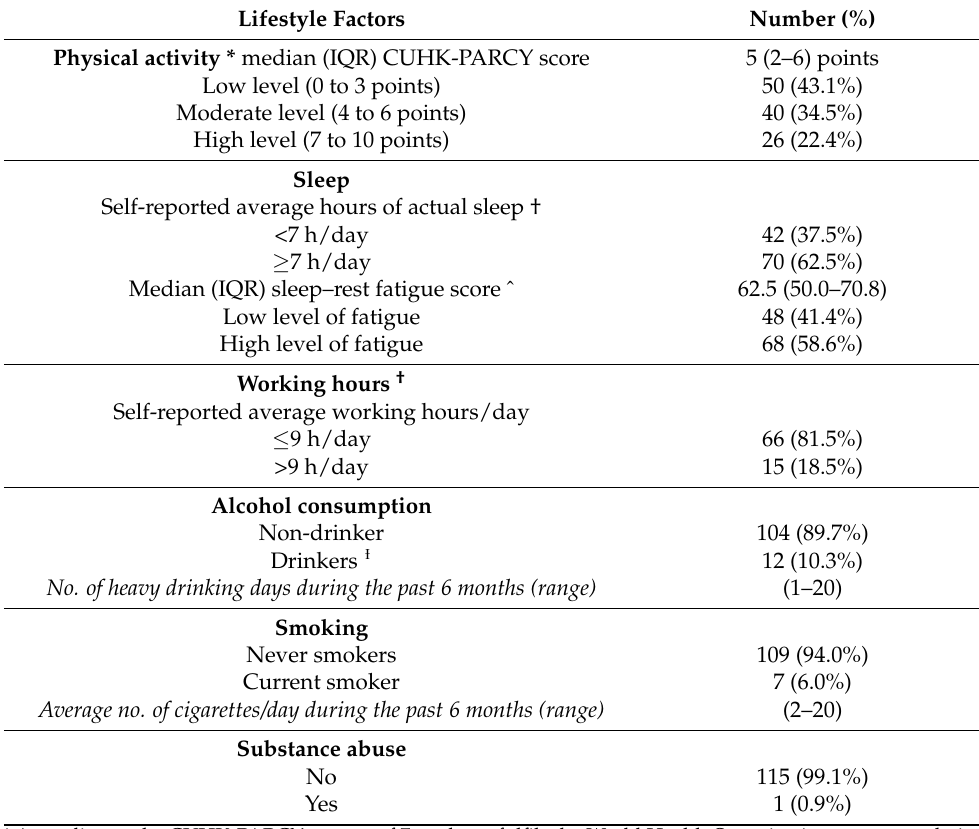
Table 4. Association between lifestyle factors and neurocognitive